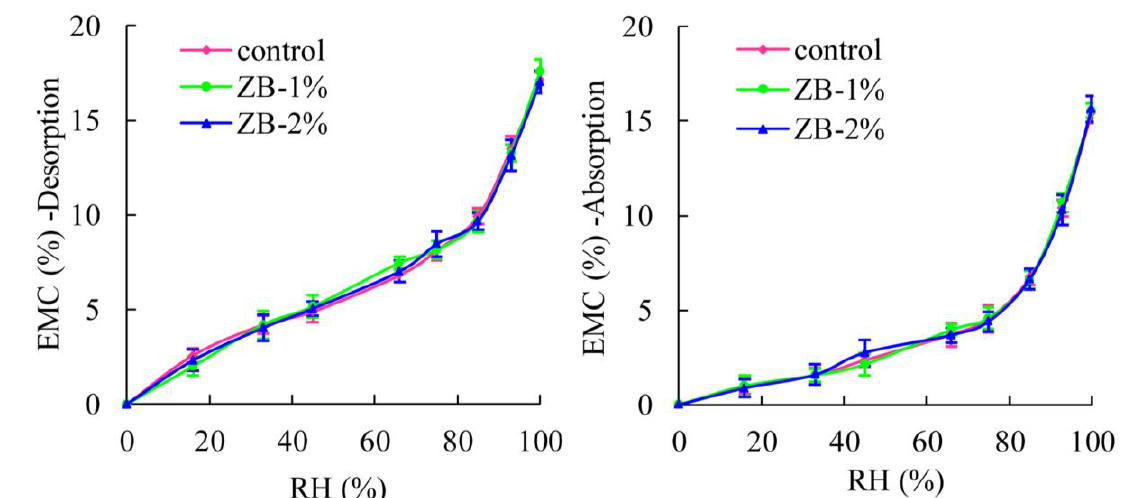
Figure 4. Effects of zinc borate (ZB) on EMC of